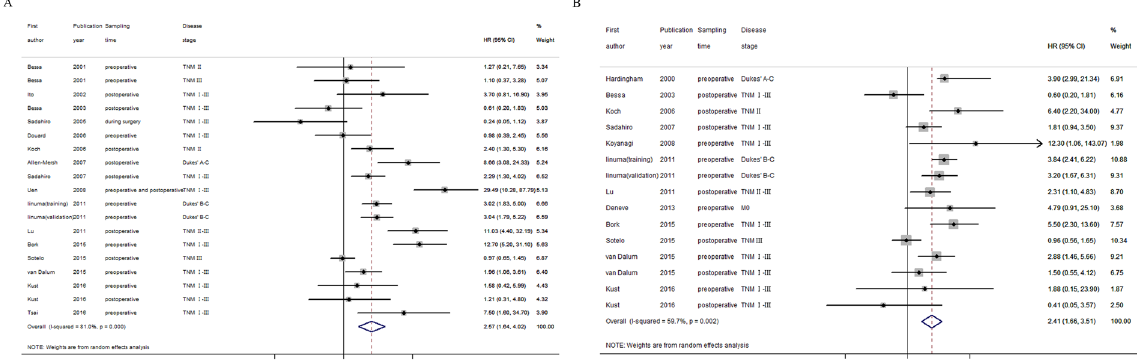
Figure 2. Overall forest plots of the prognostic effect of CTCs detected in the peripheral blood on the disease progression ( A ) or survival ( B ) in patients with non-metastatic CRC.